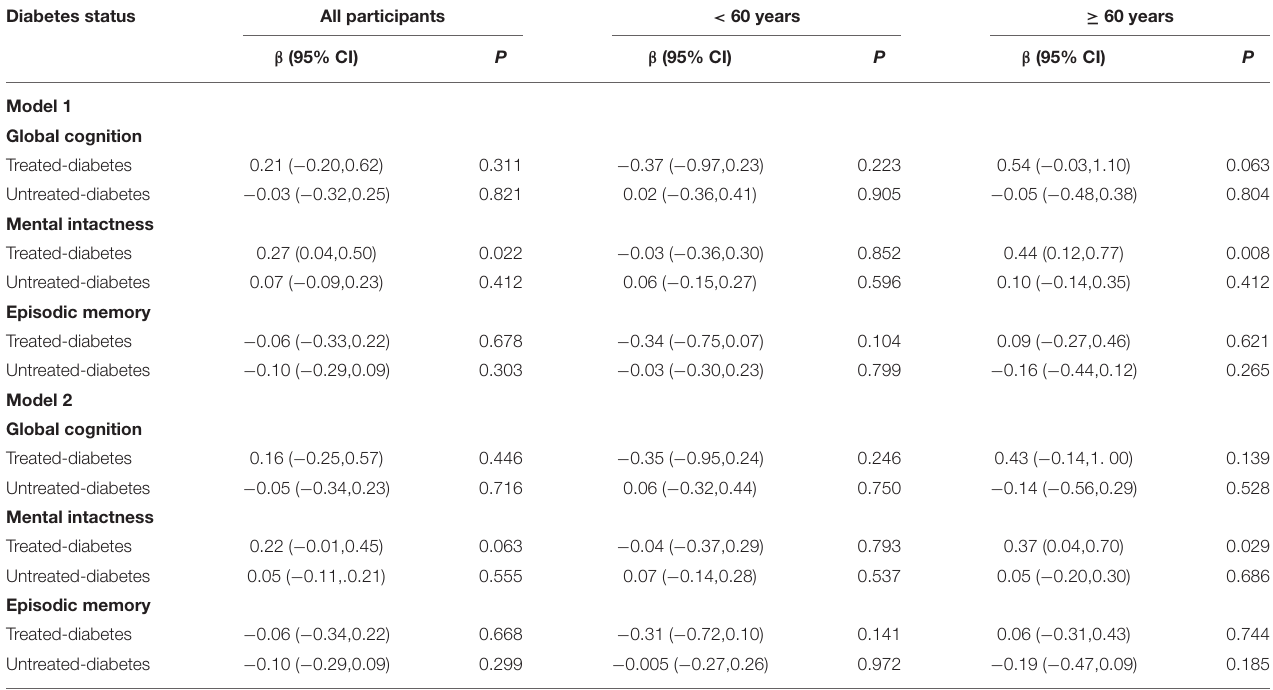
TABLE 2 | Association between diabetes status and cognitive function, using the diabetes-free group as reference. Diabetes status All